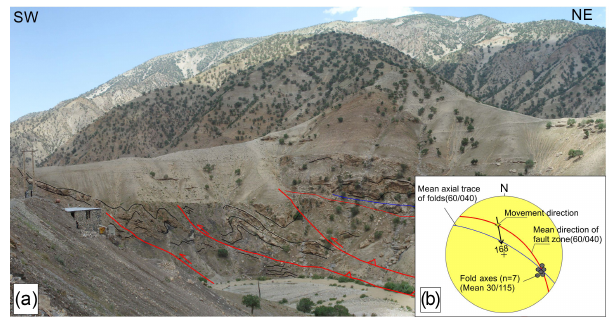
Figure 8. (a) Outcrop of the High Zagros Fault zone; (b) equal area lower hemisphere stereographic projection shows interpreted move- ment direction of High Zagros Fault zone (black arrow) using asym- metric folds’ geometries developed within the fault zone (numbers show measured attitudes). For the location refer to Fig.